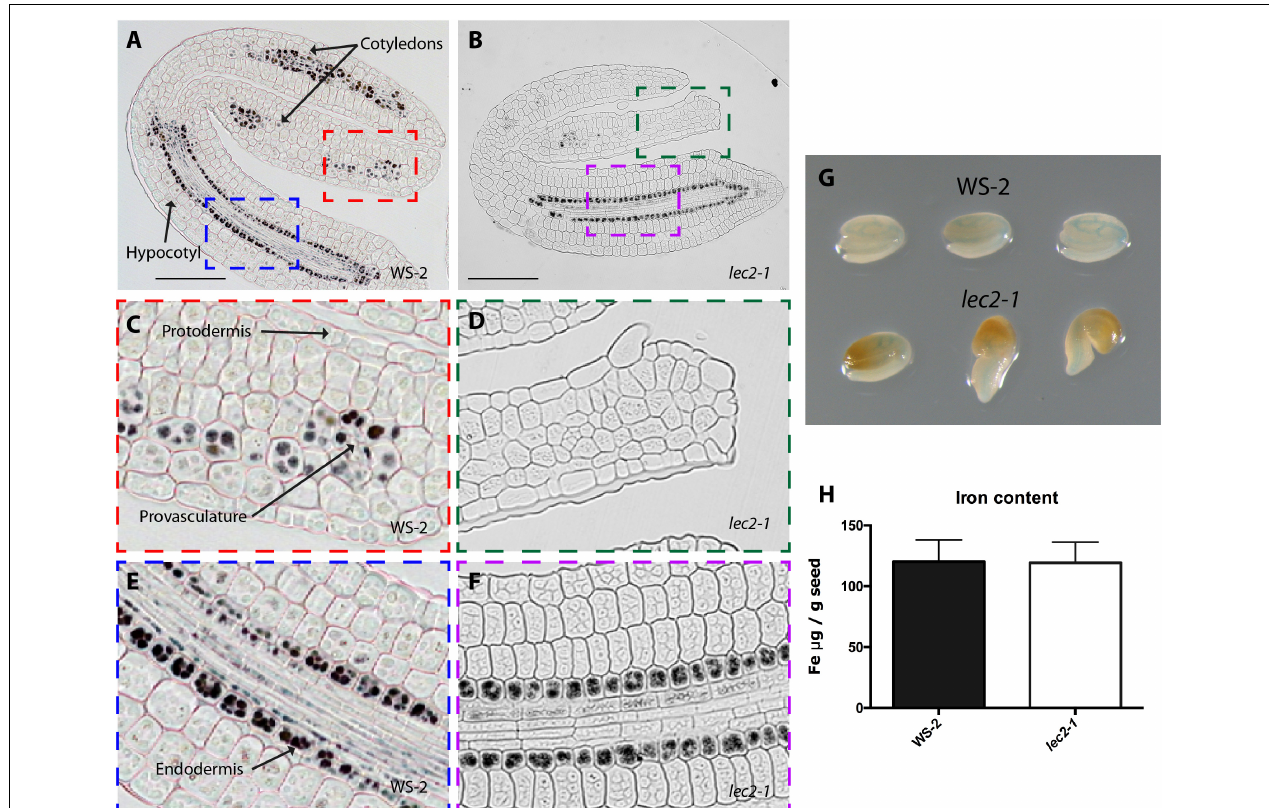
FIGURE 2 | Iron distribution and accumulation in lec2-1 mutants. Histological section of dry seed of Arabidopsis thaliana WS-2 (A,C,E) and lec2-1 (B,D,F) stained with Perls/DAB. (C,D) Cotyledons and (E,F) hypocotyl zoomed zones highlighted in colors in A and B. Bars = 100 µ m. (G) Perls staining in whole embryo, in the top row three WS-2 embryos, in the bottom row three lec2-1 . (H) Iron content in dry seed of WS-2 and lec2-1 . Four samples were analyzed for each